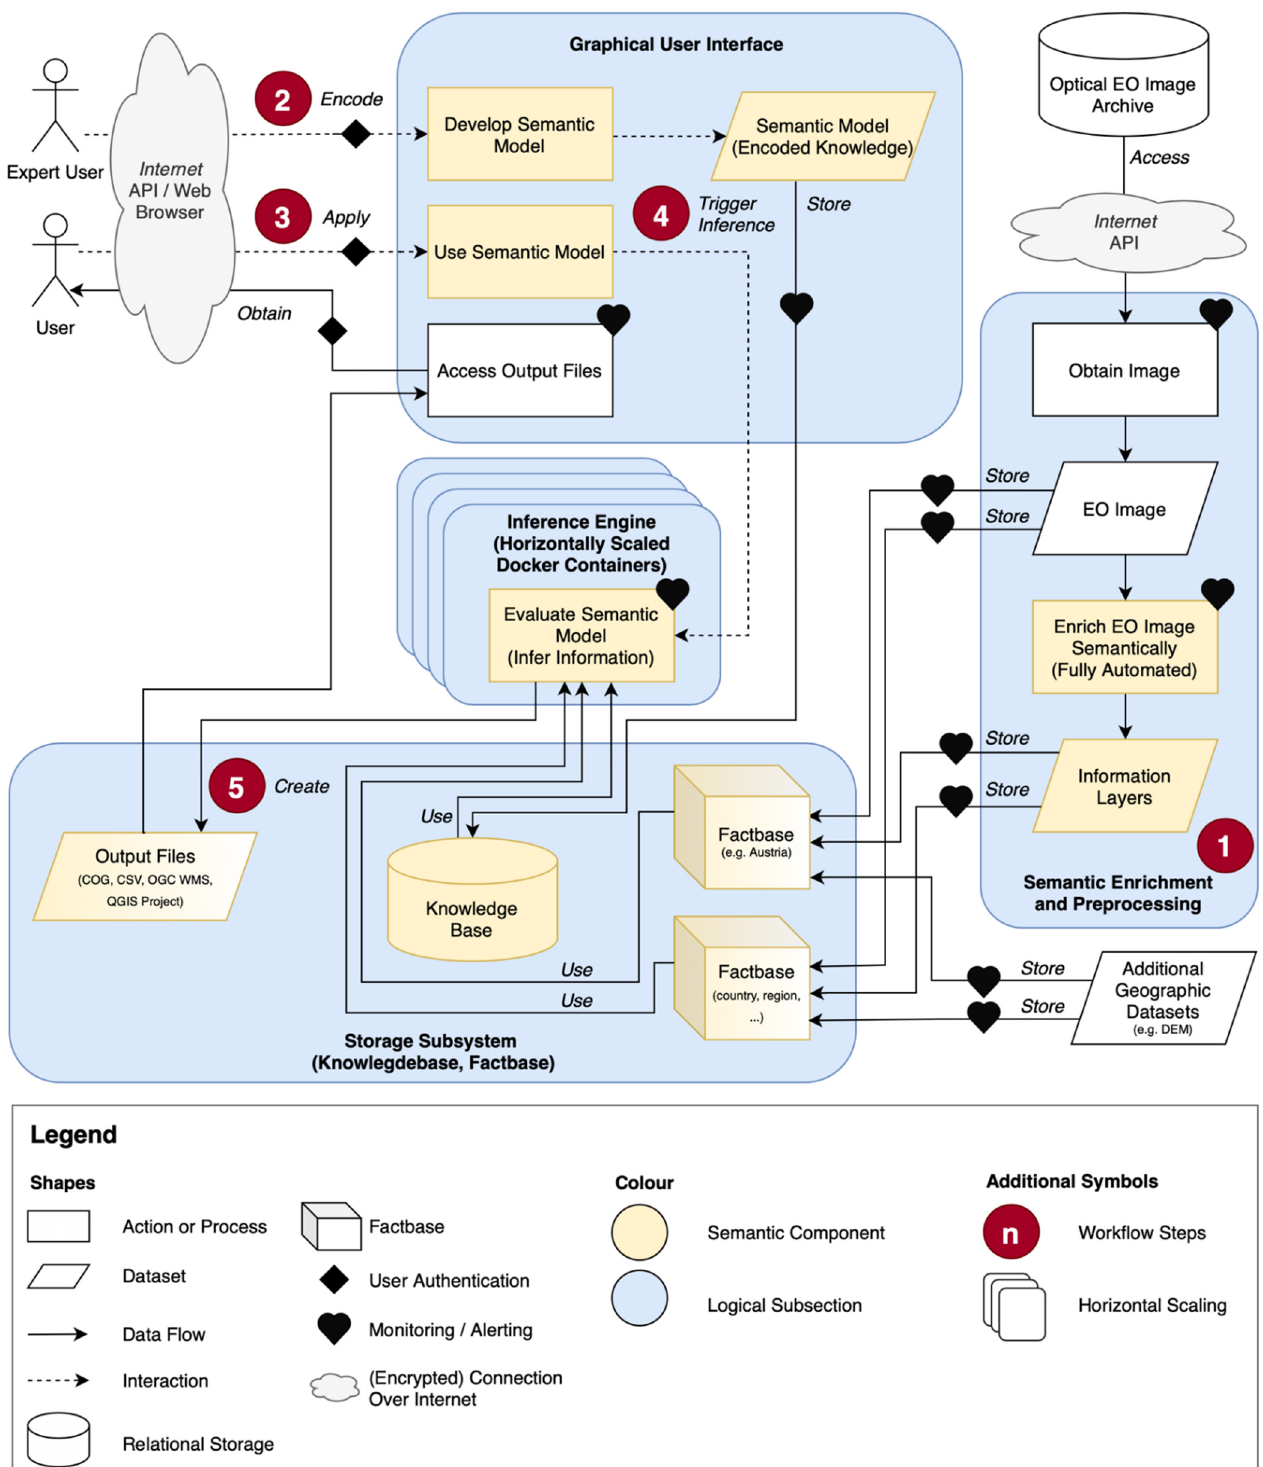
Figure 2. High-level system architecture and component orchestration. The numbers in the figure indicate the sequence of the overall workflow, including semantic enrichment (1), knowledge engineering (2), and semantic querying (3–5). The output of pre-processing is the semantic enrichment for all EO images in a unified grid and target projection available in the factbase for querying. The indexing